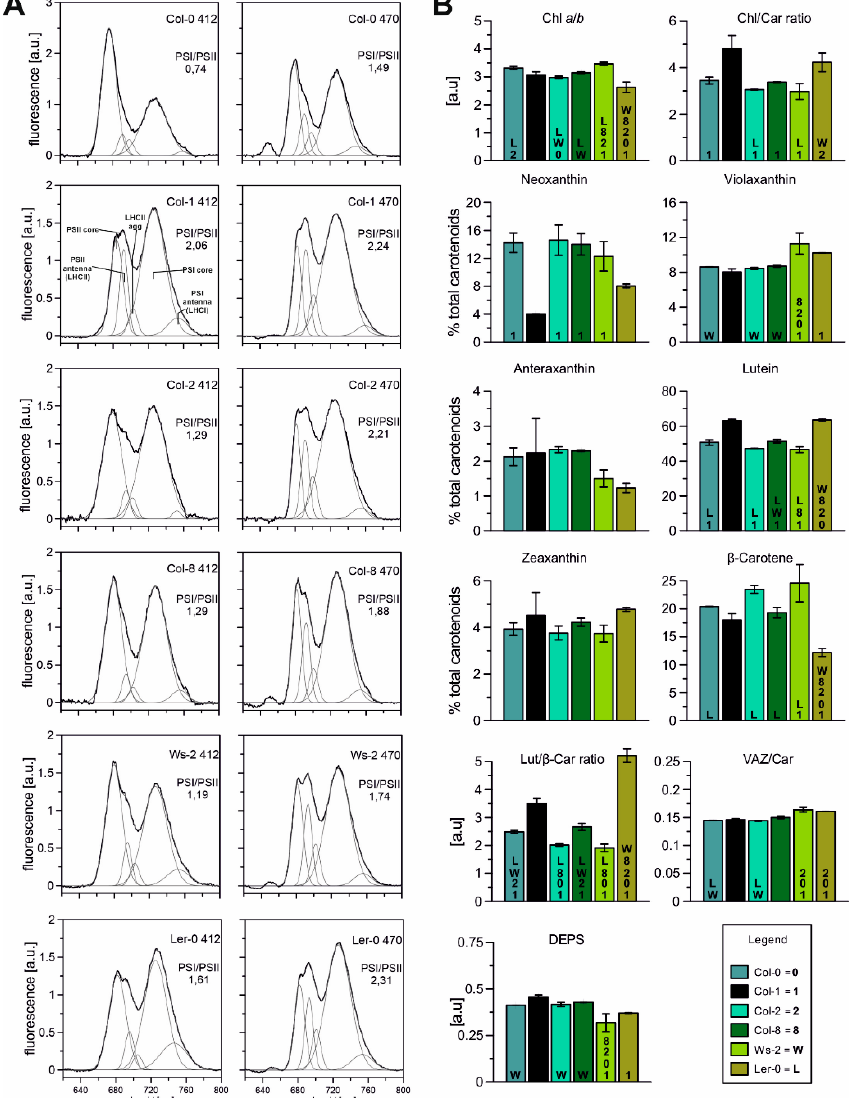
Figure 2. ( A )—Spectroscopic analysis of thylakoids isolated from Arabidopsis accessions in normal conditions. Fluorescence emission spectra at 77 K, excited at 412 and 470 nm correspond to Chl a and Chl b , respectively; Chl concentration of 10 µg/mL in 20 mM HEPES-NaOH buffer (pH 7.5) containing 15 mM NaCl, 4 mM MgCl 2 , and 80% ( v / v ) glycerol. The spectra were normalised to the area of 100 under the spectrum. The presented spectra are representative of three separate experiments. Fluorescence emission at 685 and 695 nm corresponds to the PSII core and inner antenna, at 730 and 695 nm to the PSI core and inner antenna, at 681 to the LHCII trimers (outer PSII antennae), and 700 nm to LHCII macroaggregates. ( B )—Composition of pigments (carotenoids and chlorophylls) extracted from isolated thylakoids in analysed Arabidopsis plants. The de-epoxidation state of the xanthophyll cycle pigments (DEPS) was calculated as follows DEPS = (Ax + Zx)/(Vx + Ax + Zx). The data are mean values ± SD from three independent experiments. Numbers or capital letters, according to legend, indicating significant differences between accessions ( p < 0.05), i.e., Chl a / b ratio of Col-0 is significantly bigger than in Col-2 (2) and Ler-0 (L)